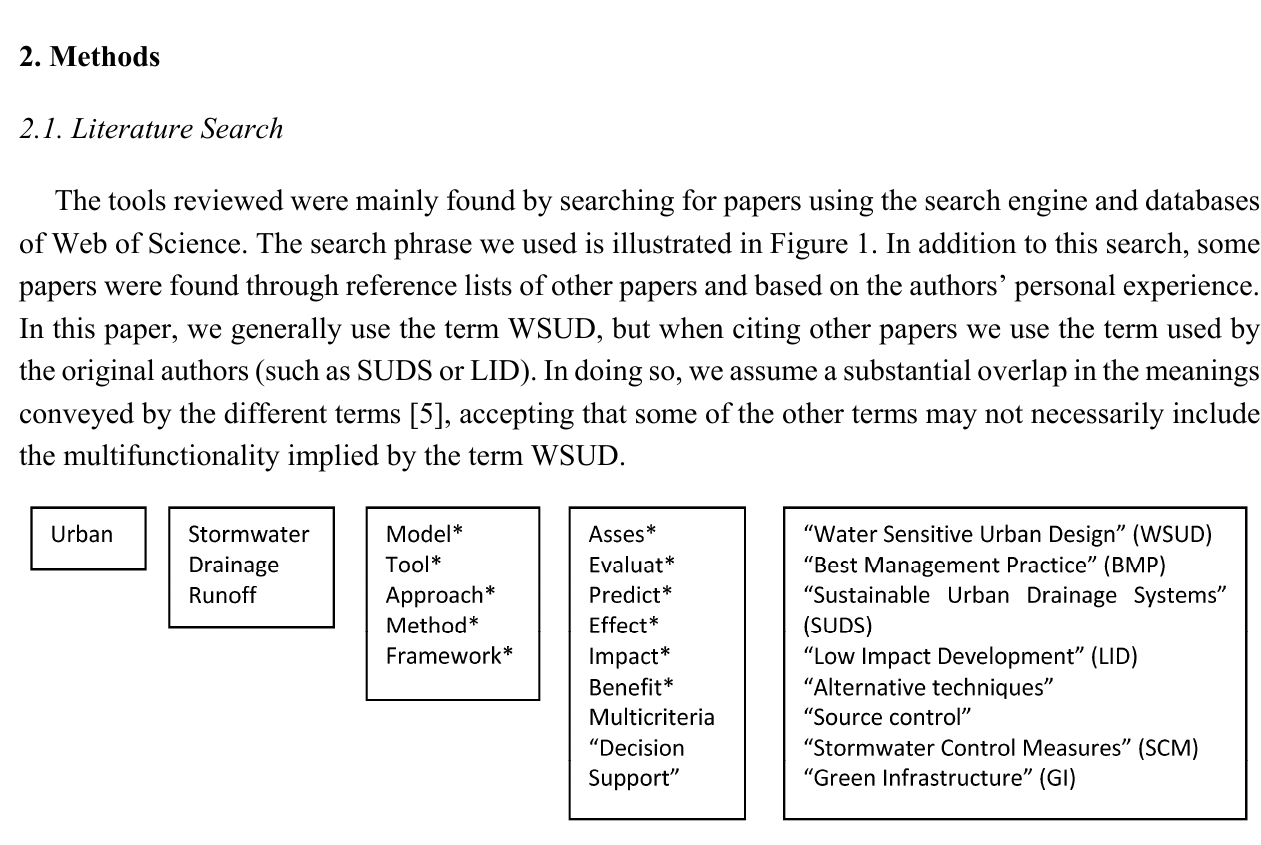
Figure 1. Illustration of the search phrase used in this study. The boxes are connected with “AND” while words within a box are connected with “OR”. An asterisk (*) represents a